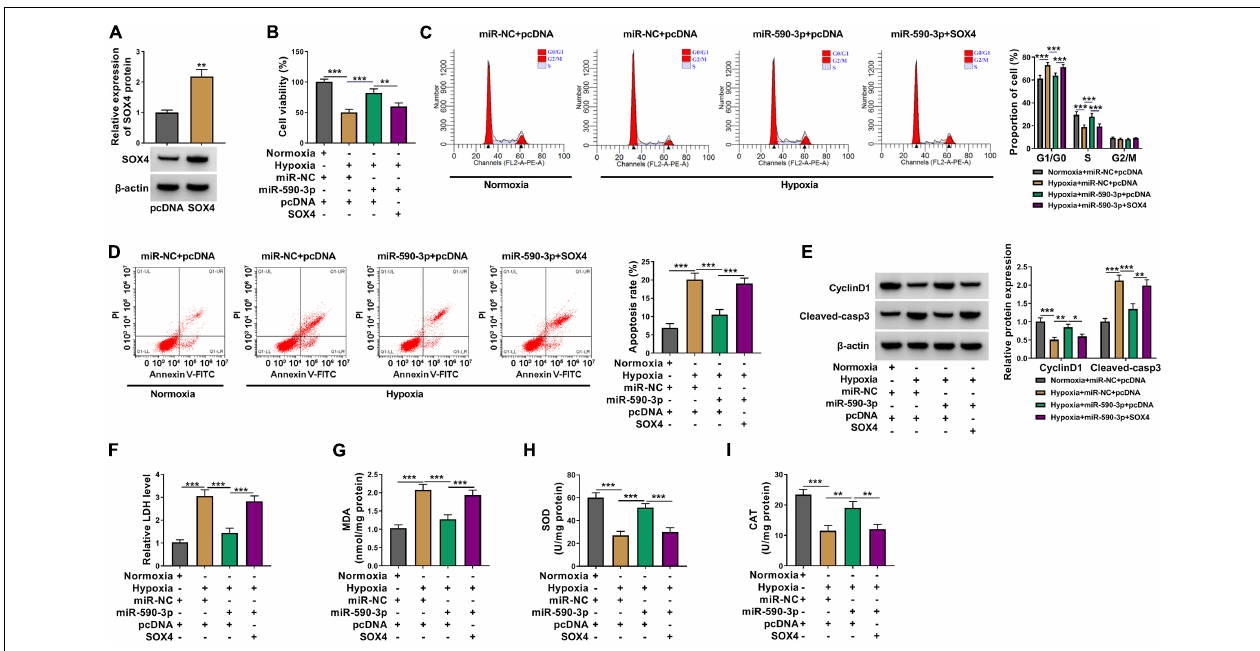
FIGURE 7 | Effects of SOX4 and miR-590-3p overexpression on hypoxia-induced cardiomyocytes injury. (A) WB analysis was used to detect SOX4 protein expression in AC16 cells to evaluate the transfection efficiency of pcDNA SOX4 overexpression vector. (B–I) AC16 cells were transfected with miR-NC + pcDNA, miR-590-3p + pcDNA, or miR-590-3p + SOX4, followed by treated with hypoxia. Normoxia-treated AC16 cells transfected with miR-NC + pcDNA were used as control. (B) Cell viability was detected by CCK8 assay. (C,D) Flow cytometry was utilized for assessing cell cycle distribution and cell apoptosis. (E) WB analysis was used to test the protein levels of CyclinD1 and Cleaved-casp3. (F–I) Corresponding Assay Kits were employed to detect the levels of LDH, MDA, SOD, and CAT. * P < 0.05, ** P < 0.01, *** P <